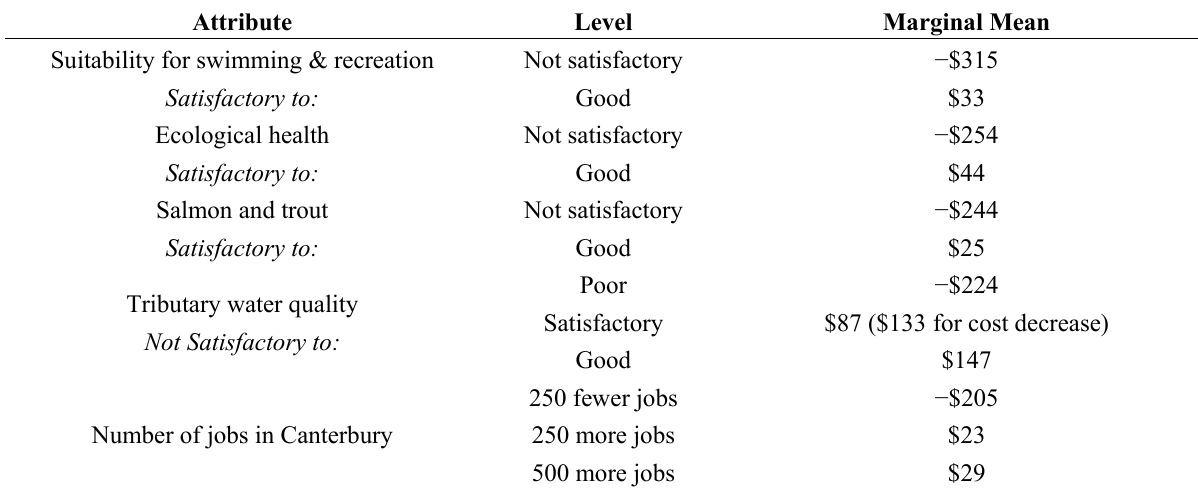
Table 6. Willingness to pay or accept